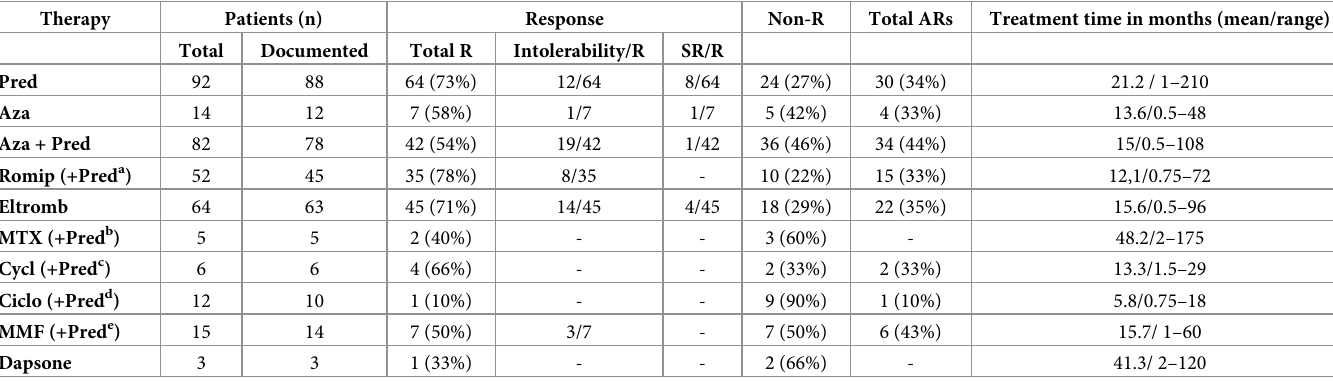
Table 2. Results of continuous treatments in patients with ITP during observation at our institution (n = 234). Therapy